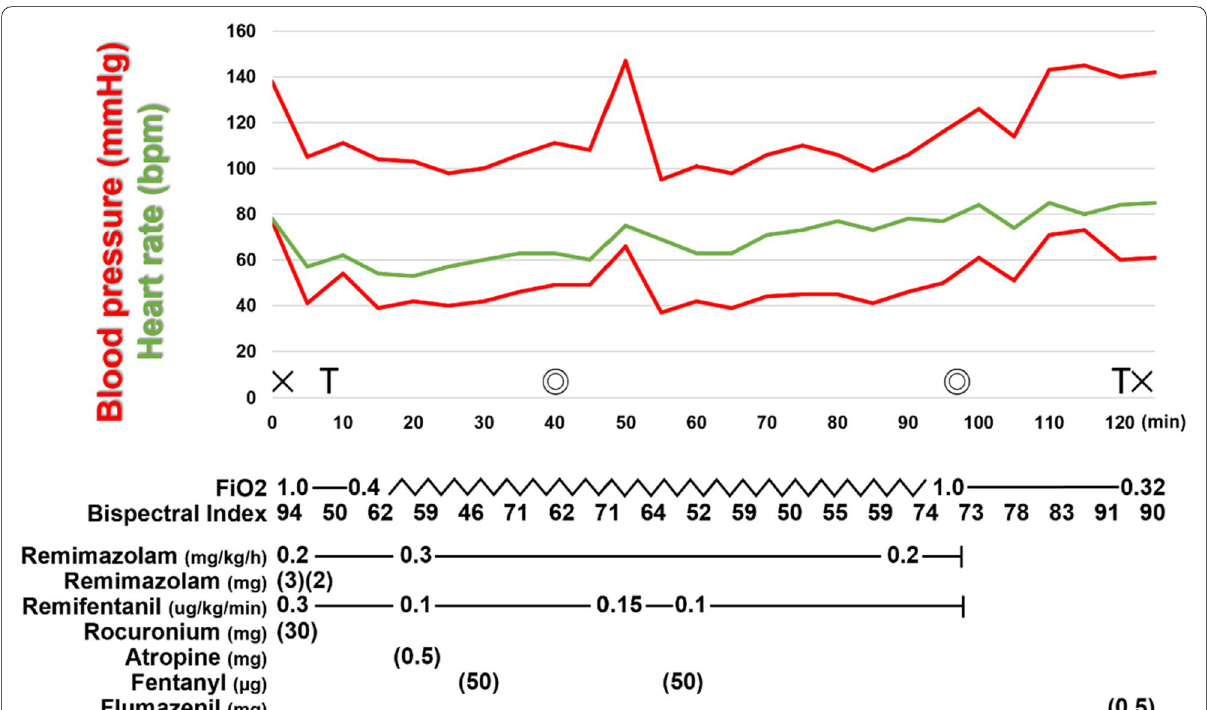
Fig. 1 Time course of general anesthesia. During general anesthesia, the patient’s hemodynamics were stable and neither hypotension nor tachycardia was observed. Spontaneous respiration appeared shortly after the end of remimazolam administration, but the patient was unable to follow the indicated actions due to a lack of arousal. The patient’s level of consciousness did not improve even after 25 min had passed. The patient awoke promptly with 0.5 mg of flumazenil, allowing tracheal extubation. , the start and end of general anesthesia; T, tracheal intubation and × extubation; ◎ , the start and end of